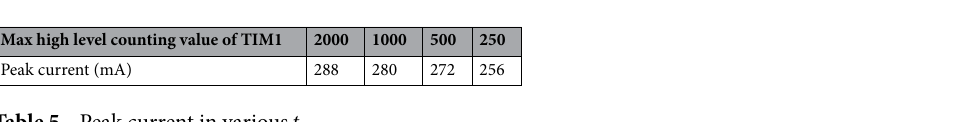
Table 5. Peak current in various t on